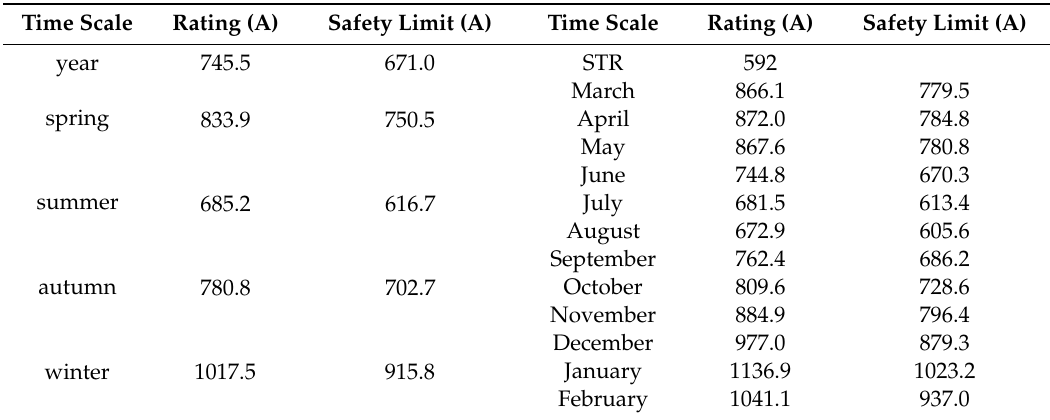
Table 6. Safety limit of quasi-dynamic thermal